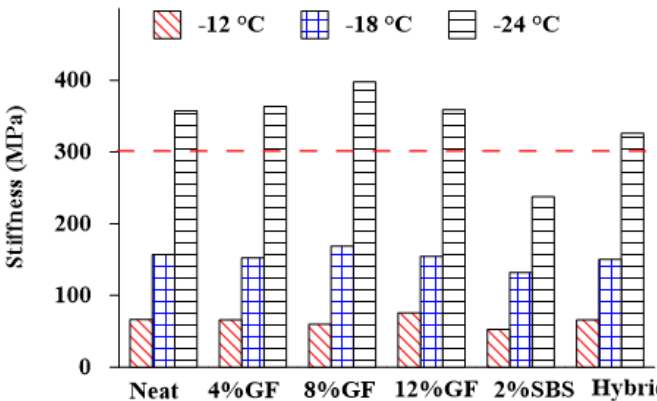
Figure 8. Effect of additives on the creep